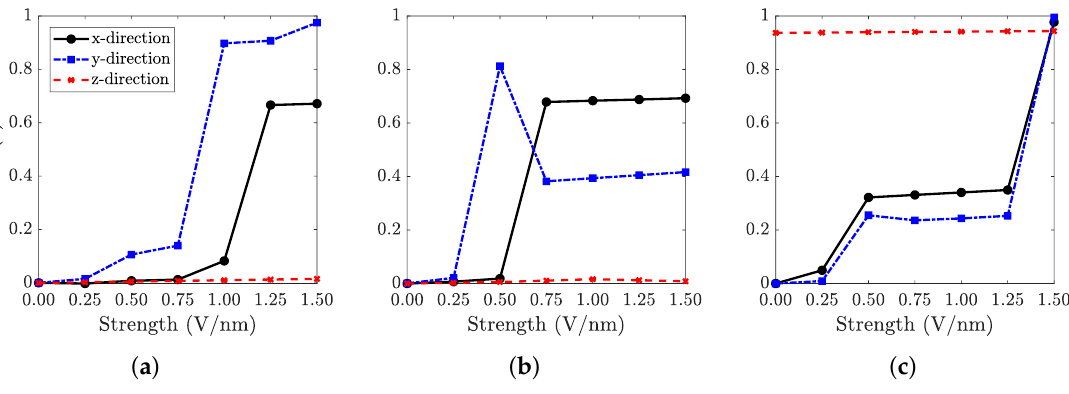
Figure 9. Time-averaged < cos ( θ ) > values for the cases where an e-field was applied on ( a ) initially α -glycine, ( b ) initially β -glycine, ( c ) initially γ -glycine crystals. Lines are there to guide the